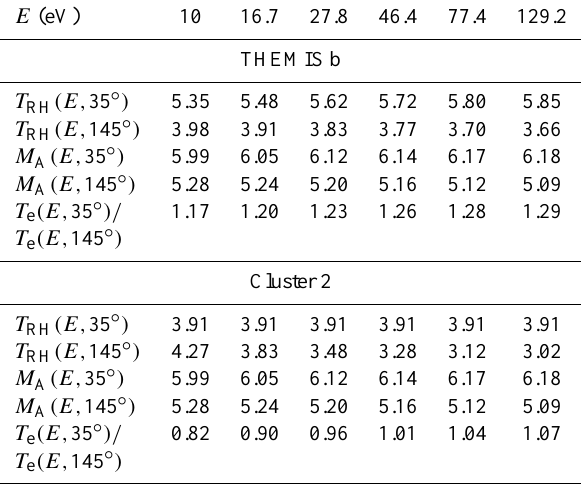
Fig. 9. Plot of δT k (α) and δT ⊥ (α) defined by Eqs. (4) and (5) and show the contribution to the temperature moment of electrons as a function of α . For T k the max is at ∼ 35 ◦ and ∼ 145 ◦ . Asymmetries are especially visible for THEMIS b.